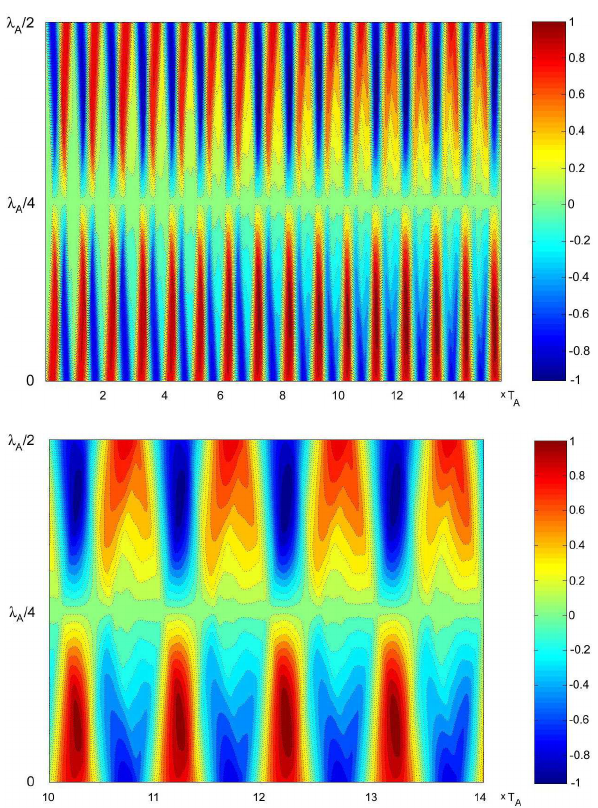
Fig. 2. Spatial and temporal dependence of the magnetic field per- turbation B y . Horizontal axes give the time in T A units, and vertical axes give the length along the simulation box in λ A units. Color scale shows the magnitude of B y . ( a ) Time interval (0–15 T A ) ; ( b ) time interval (10–15 T A ) .